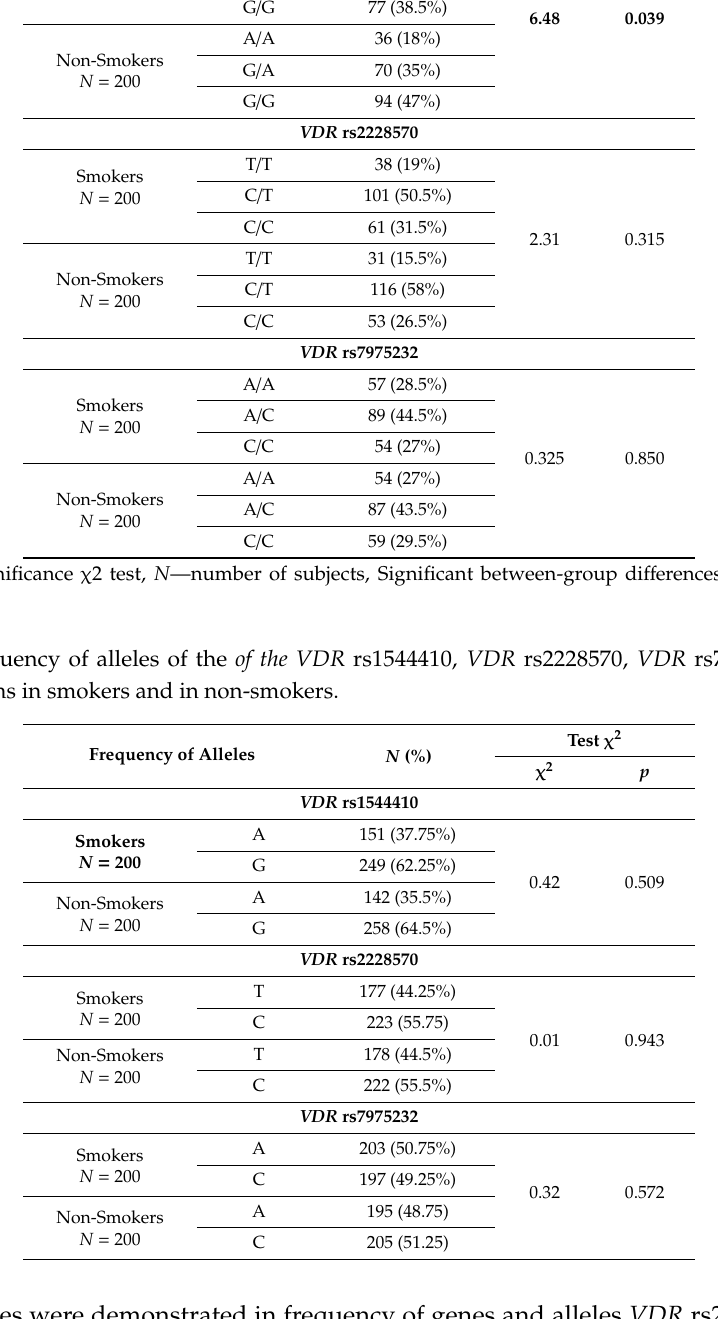
Table 2. Frequency of genotypes of the VDR rs1544410, VDR rs2228570, VDR rs7975232 genes polymorphisms in smokers and in non-smokers. Frequency of Genotypes N (%)